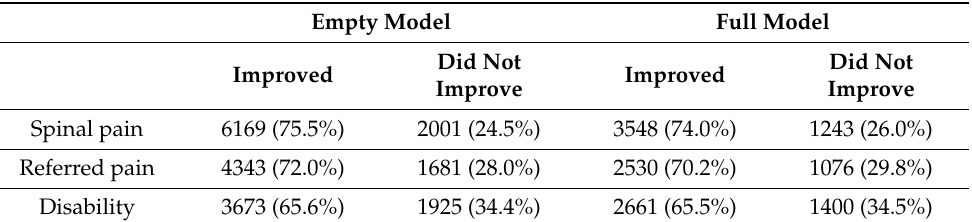
Table 9. Proportion of patients who improved and did not improve in the empty and full models.